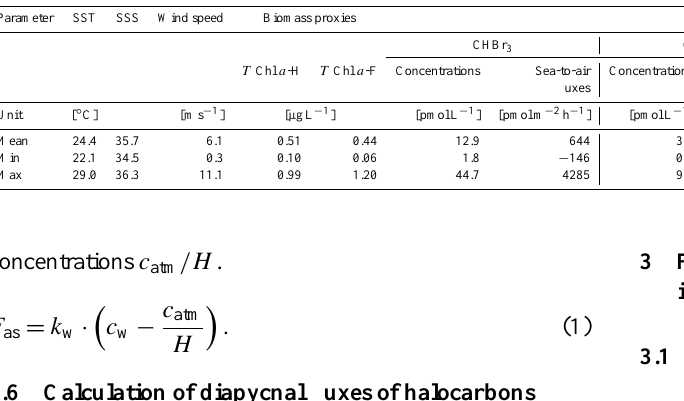
Table 1. Mean (minimum – maximum) values of physical parameters (sea surface temperature (SST), sea surface salinity (SSS), and wind speed), surface biomass proxies ( T Chl a -H: T Chl a from HPLC measurements, T Chl a -F: T Chl a determined from the continuously measuring fluorescence sensor), and sea surface concentrations, as well as sea-to-air fluxes of the four halocarbons CHBr 3 , CH 2 Br 2 , CH 3 I, and CH 2 I 2 during the cruise